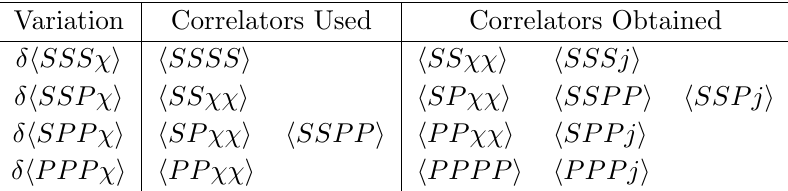
Table 2 . Taking supersymmetric variations to compute correlators. By setting the variation in the (cid:12)rst column to zero, we can use the correlators in the second column to compute the correlators in the third